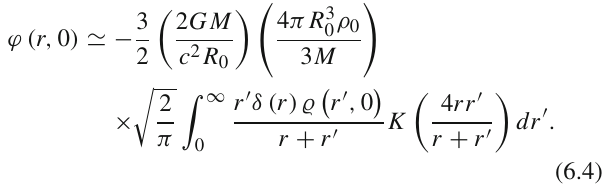
Fig. 2 The left-hand side graphic shows a comparison between the fitted rotation curve and the standard definition of the circular veloc- ity of a compact spheroid. The right-hand side graphic shows that the Miyamoto–Nagai solution fails to reproduce the luminosity profile of